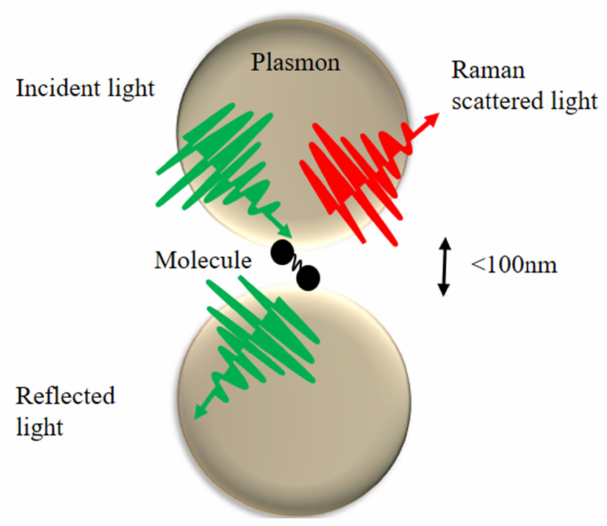
Figure 2. Plasmonic effects: Electric Field around two nanoparticles and the presence of a SERS